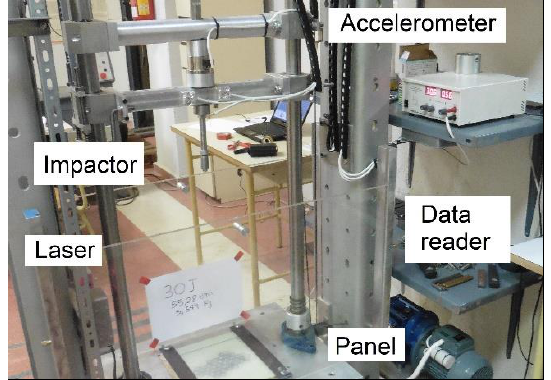
Figure 5. Weight drop impact equipment.